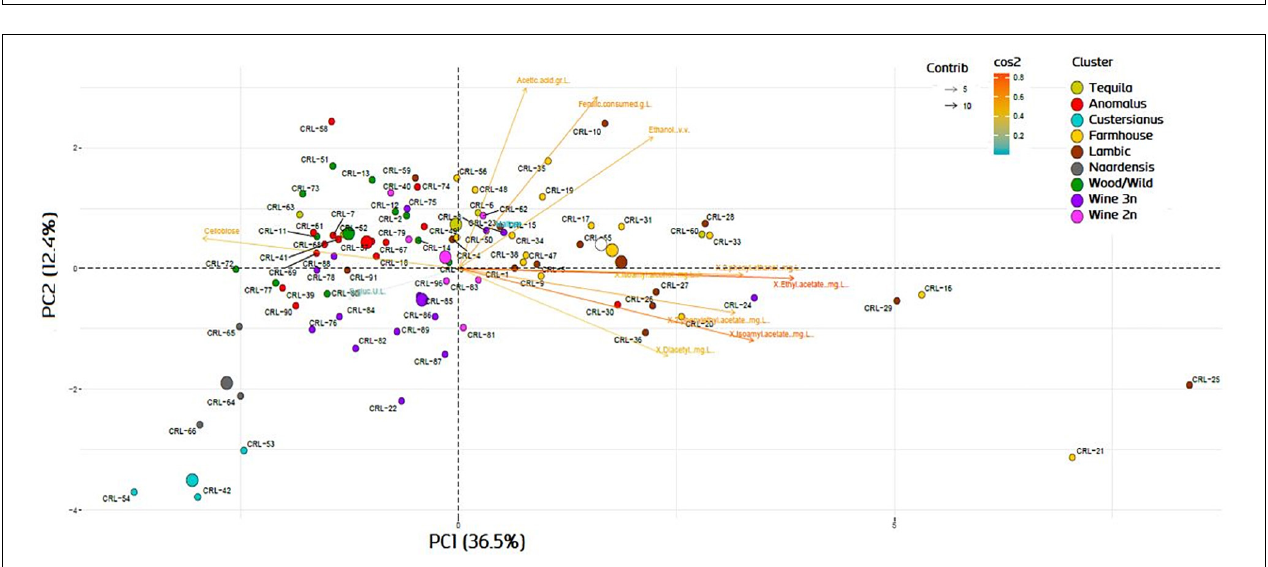
FIGURE 9 | Violin plot with phenotypical measurements of Brettanomyces population. Strains are grouped according to the genomic cluster assigned in Figure 2 .